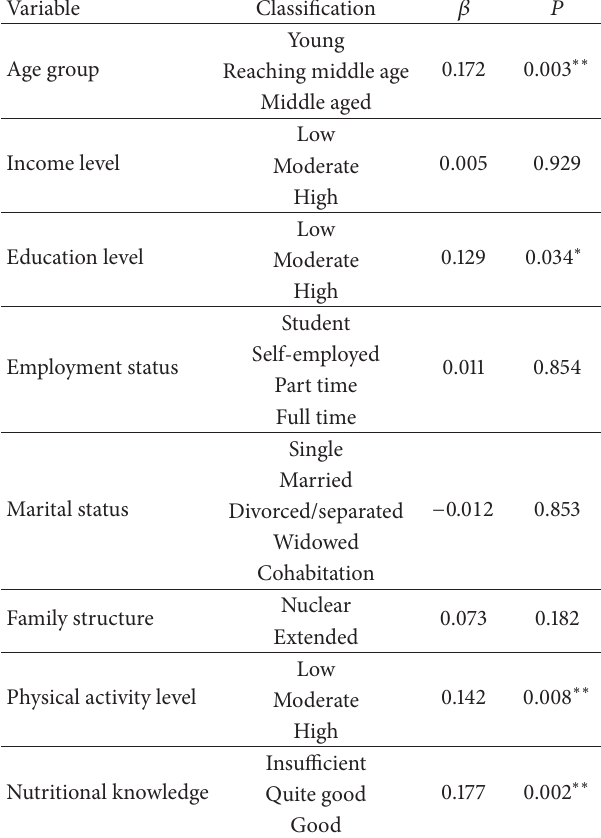
Table 4: Age group, income level, education level, employment status, marital status and family structure, physical activity level, and nutritional knowledge as determinants of dietary